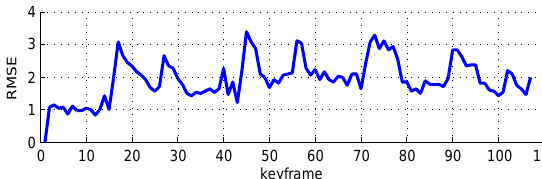
Figure 8: Root mean square error (RMSE) for each keyframe set.